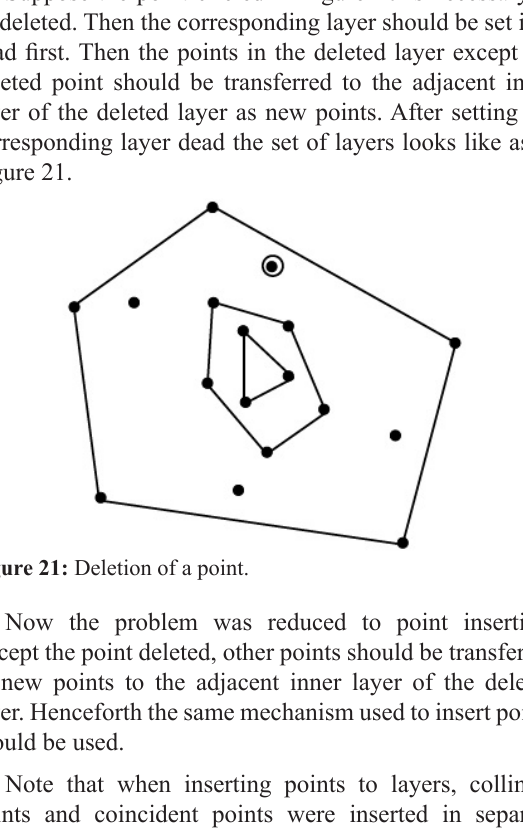
Figure 19: Final form of the layer.